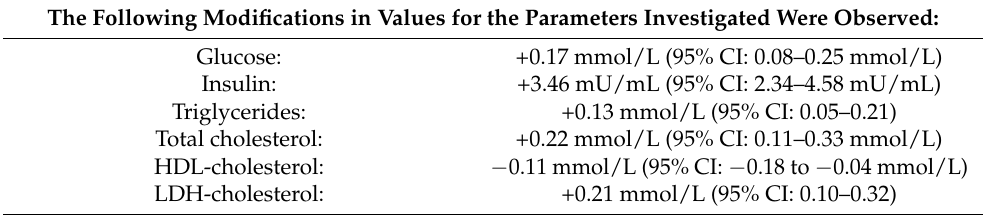
Table 2. Biochemical cardiovascular risk factors after hypertensive pregnancy